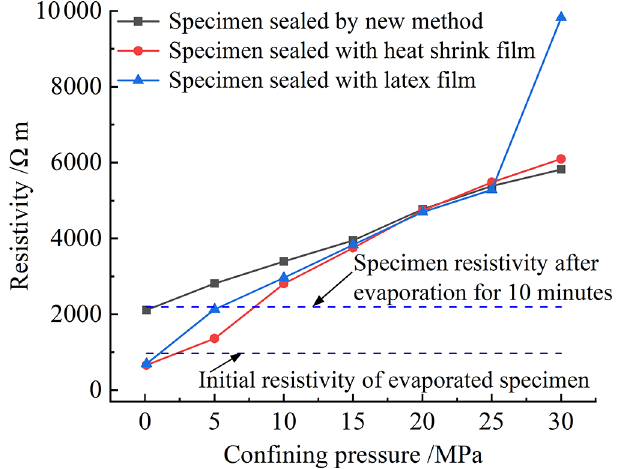
Figure 7. Changes in the resistivity of sealed specimens by different methods under confining pressure.